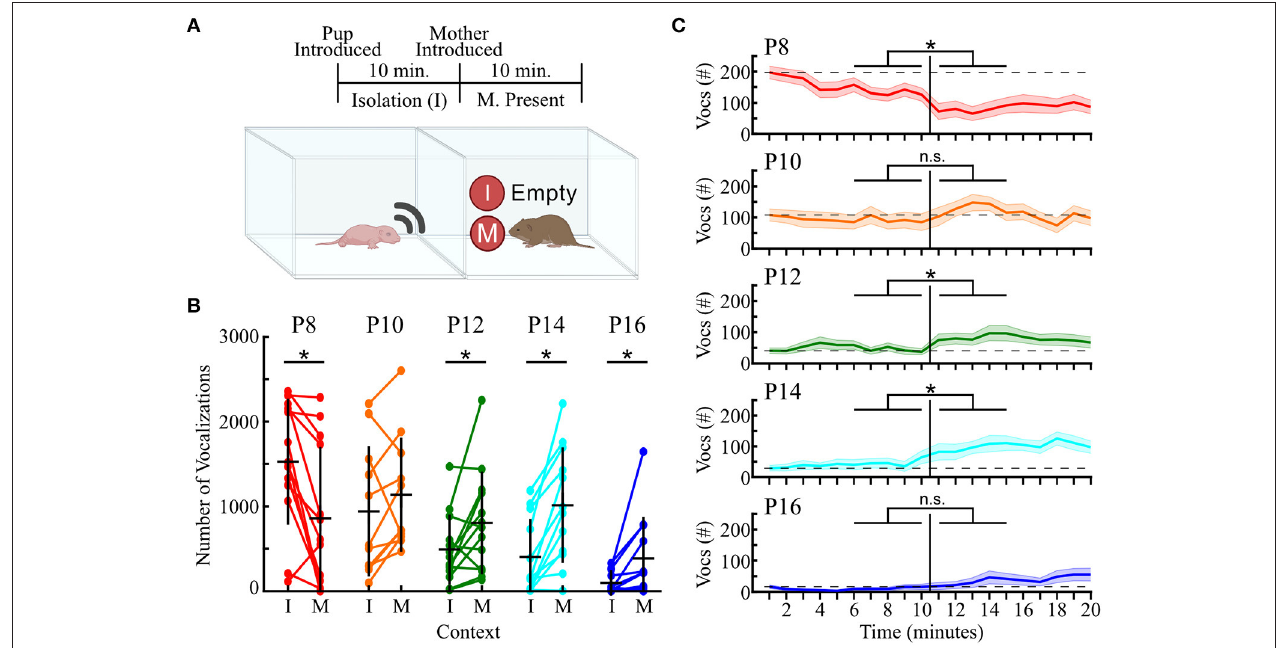
FIGURE 7 | Vocal responses to social context change with pup age. (A) Timeline (top) and schematic (bottom) of the two recording contexts. I, isolation; M, mother present. Pup was audio- and video-recorded in each context. (B) Dots indicate the number of calls emitted while a pup was in isolation (left; I) or while their mother was in an adjacent but physically distinct chamber (right; M), with lines connecting the same pup across contexts. n = 11, 11, 13, 12, and 12 for P8, 10, 12, 14, and 16, respectively. Horizontal black lines represent group means, and vertical black lines represent standard deviations. Mixed factorial ANOVA indicated a main effect of age and social context, and a significant age-by-context interaction (all p ≤ 0.001). Then paired t -tests compared contexts within age. *Significant comparison after a Benjamini-Hochberg post-hoc correction. (C) Number of vocalizations emitted by pups in each 1-min bin over the 20-min recording. Colored horizontal lines indicate mean values across animals, with shaded areas representing ± 1 SEM. Vertical black line indicates time when the mother was introduced. Horizontal dashed line shows the average number of USVs emitted during the first minute of isolation. Colors as in (B) . * p < 0.05 when comparing the total number of vocalizations in the final 5min of isolation (left) vs. the first 5min after the mother was introduced (right) across all pups (paired t -test with Benjamini-Hochberg post-hoc correction for multiple comparisons).